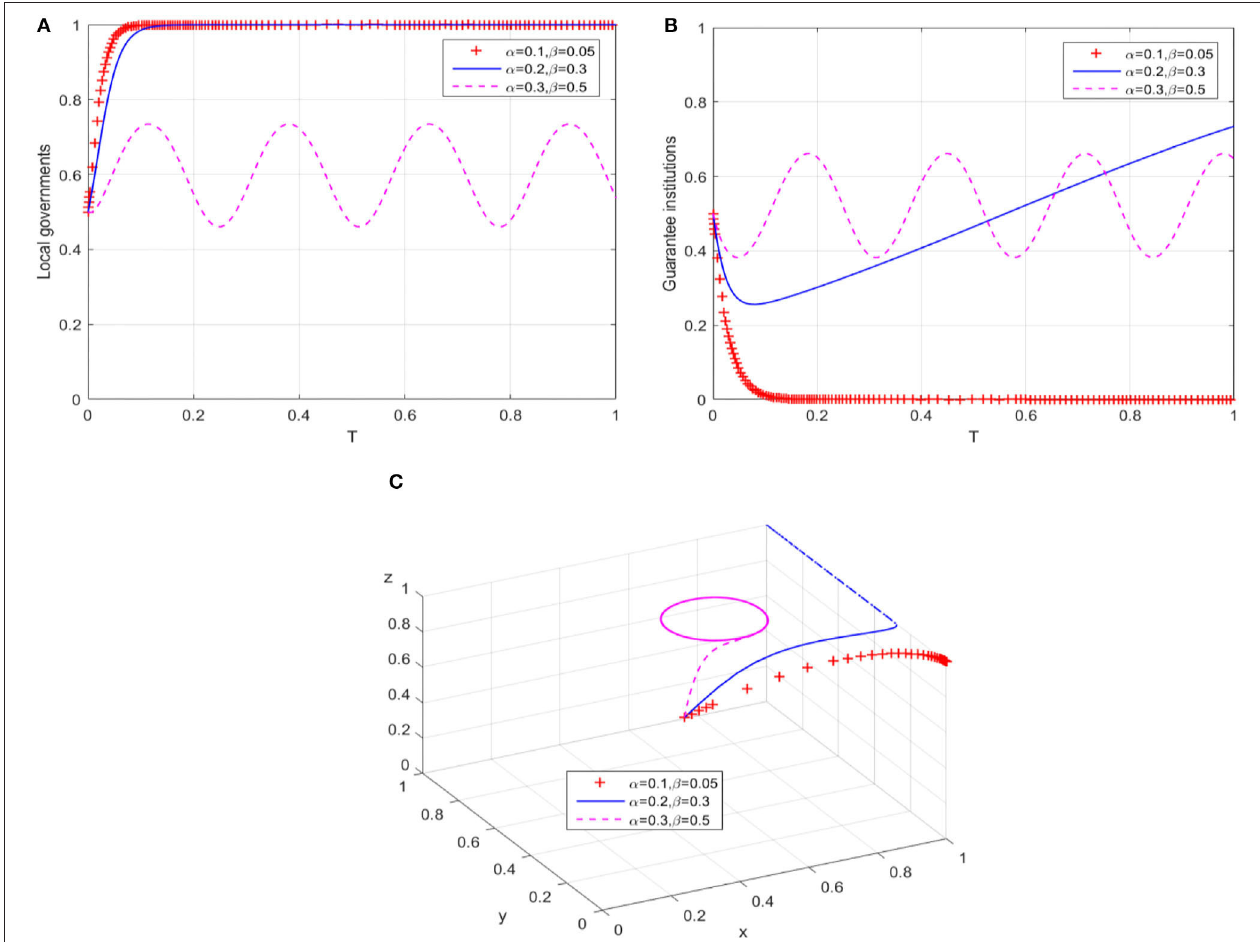
FIGURE 3 | The breakthrough effect of path 2 on low-level equilibrium. (A) Local governments (B) Guarantee institutions. (C) Game system of financing guarantee